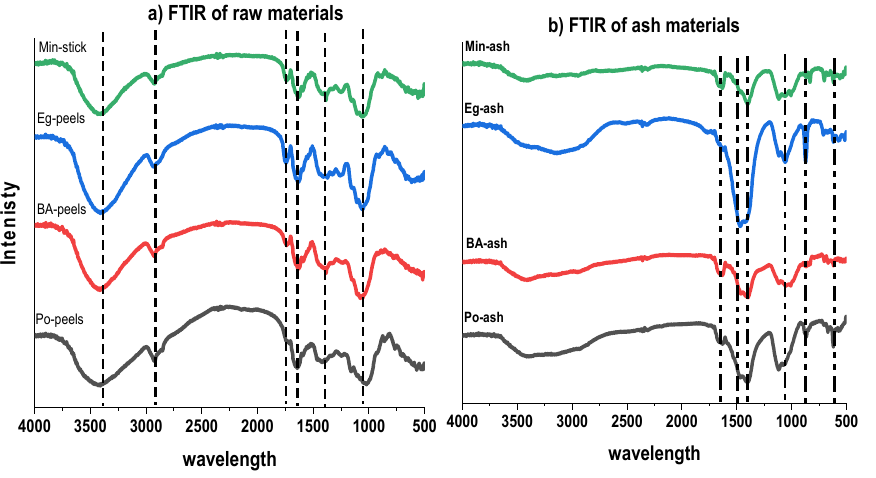
Figure 4. FTIR spectra: ( a ) raw materials; ( b ) ash materials. Table 4. Changes in water quality after adding 10 g/L of ash materials in 1000 ppm Ca ions.